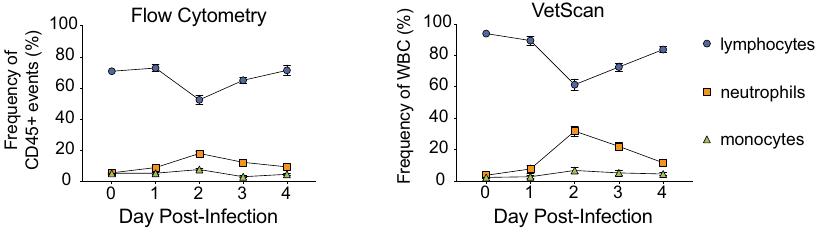
Fig 4. Flow cytometry and VetScan hematological data are highly correlated. (A) Pearson Correlation analysis of data from mock infected mice. Lymphocyte (left), neutrophil (center) and monocyte (right) cell frequencies measured by VetScan (x-axes; frequency of WBC) and flow cytometry (y-axes; frequency of CD45 + events) from peripheral blood. (B) Pearson Correlation analysis data from MERS-CoV infected mice similar to that of A . For A and B , the correlation coefficient (R squared) and p-values obtained are indicated in each plot. (C) The kinetic frequencies of blood lymphocytes (circles), neutrophils (squares) and monocytes (triangles) in MERS-CoV infected mice through day 4 post-infection, as measured by flow cytometry (left) and VetScan (right). Time “zero” was generated from mock infected animal data to represent the baseline values. Each symbol represents merged values for 8 animals across two independent experiments; error bars identify median ±